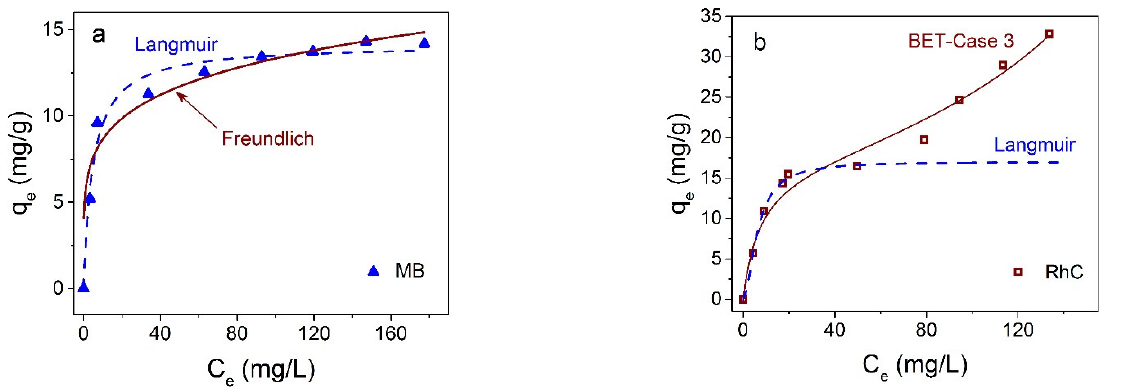
Figure 11. Adsorption isotherms of MB and RhC on Fe 3 O 4 @C NPs at at 25 ◦ C—( a , b ), correspondingly. Solid lines correspond to fitting to Freundlich ( a ) and BET ( b ) models, dotted lines to Langmuir